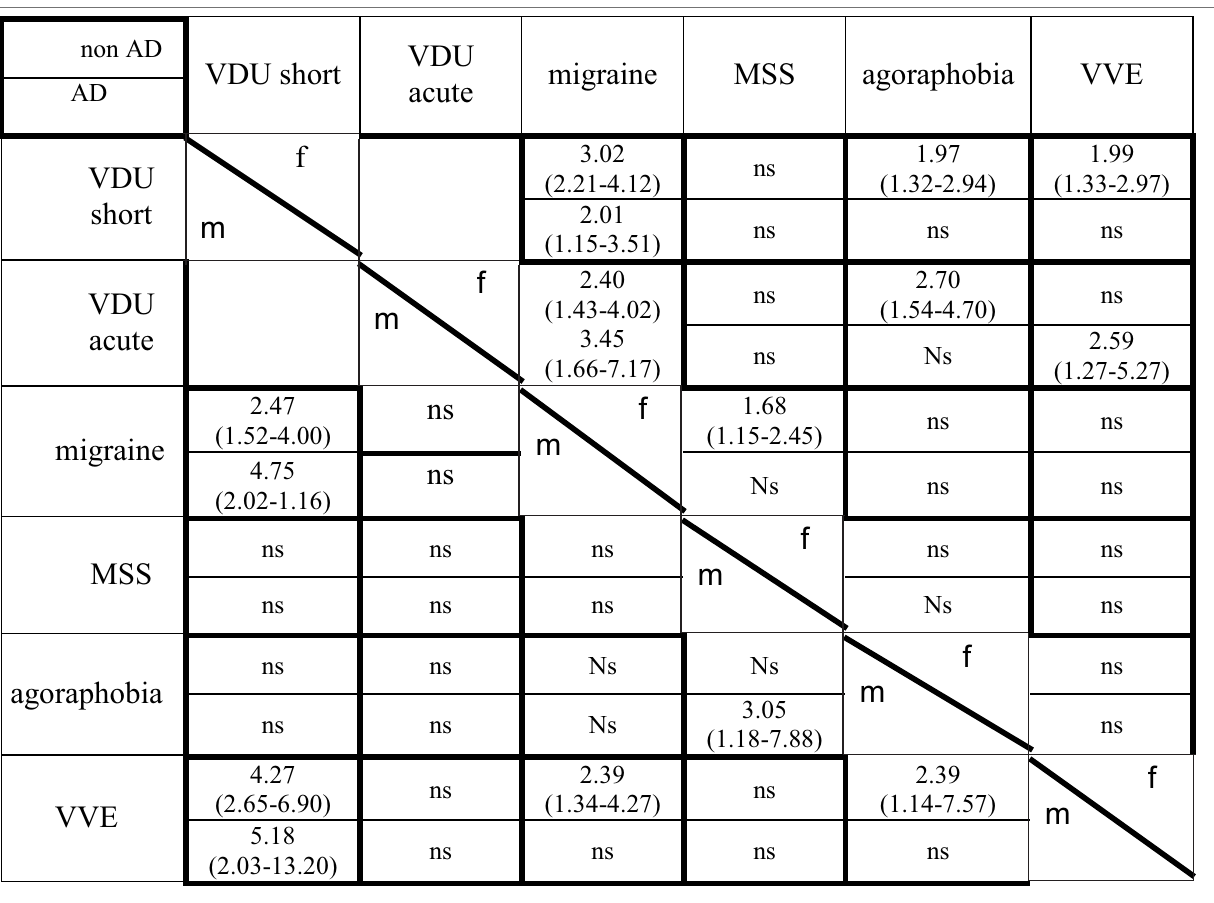
Table 6 |VDU and co-morbidities controlled for gender and